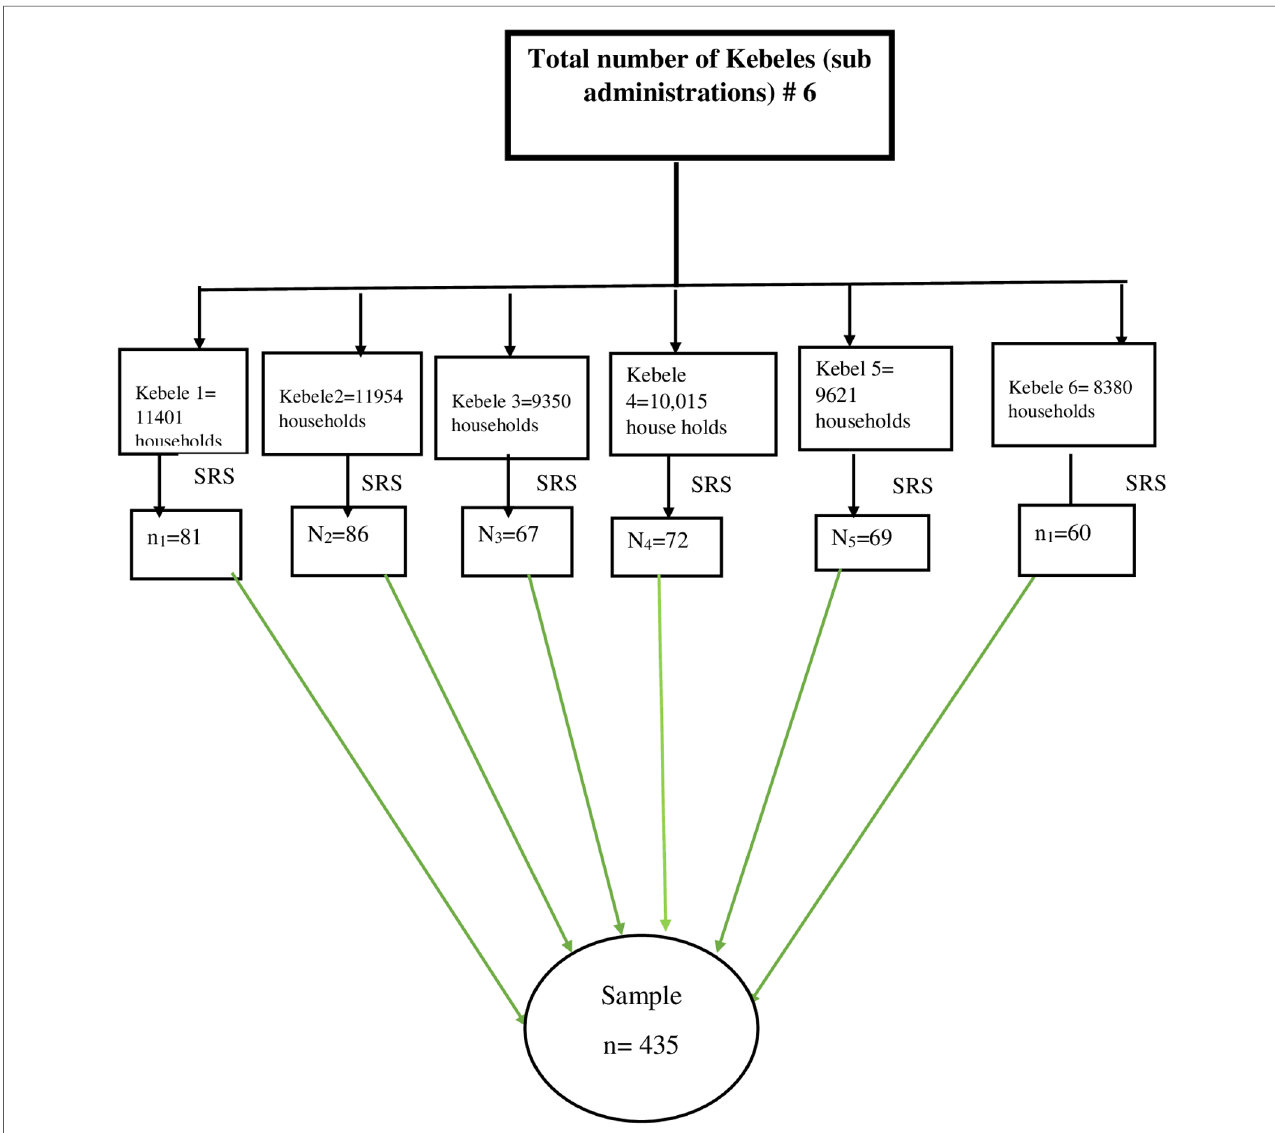
FIGURE 1 Schematic presentation of the sampling procedure for the assessment childhood vaccination practices among mothers/care givers, 2022 ( n